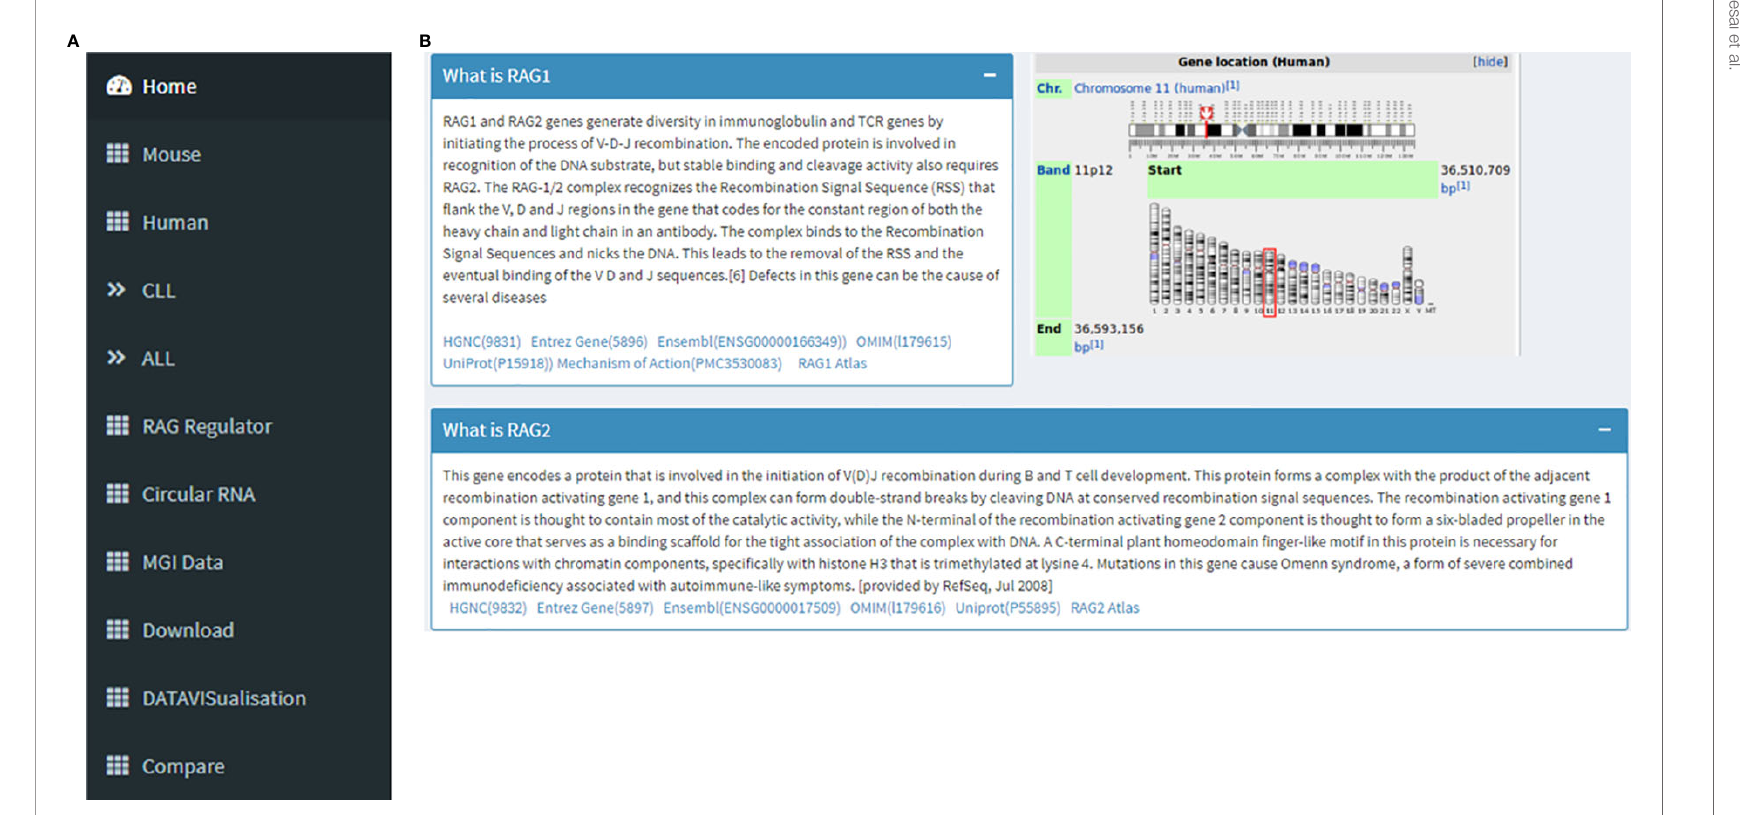
FIGURE 1 | (A) Navigation panel that contains links to all the pages of the database. (B) This image collectively gives an introduction to RAG1 and RAG2, its function and its chromosomal location. It can also be seen that there are links to RAG1 related pages of HGNC, Entrez Gene, Ensembl, OMIM, UniProtKB, Atlas of Genetics and Cytogenetics in Oncology and